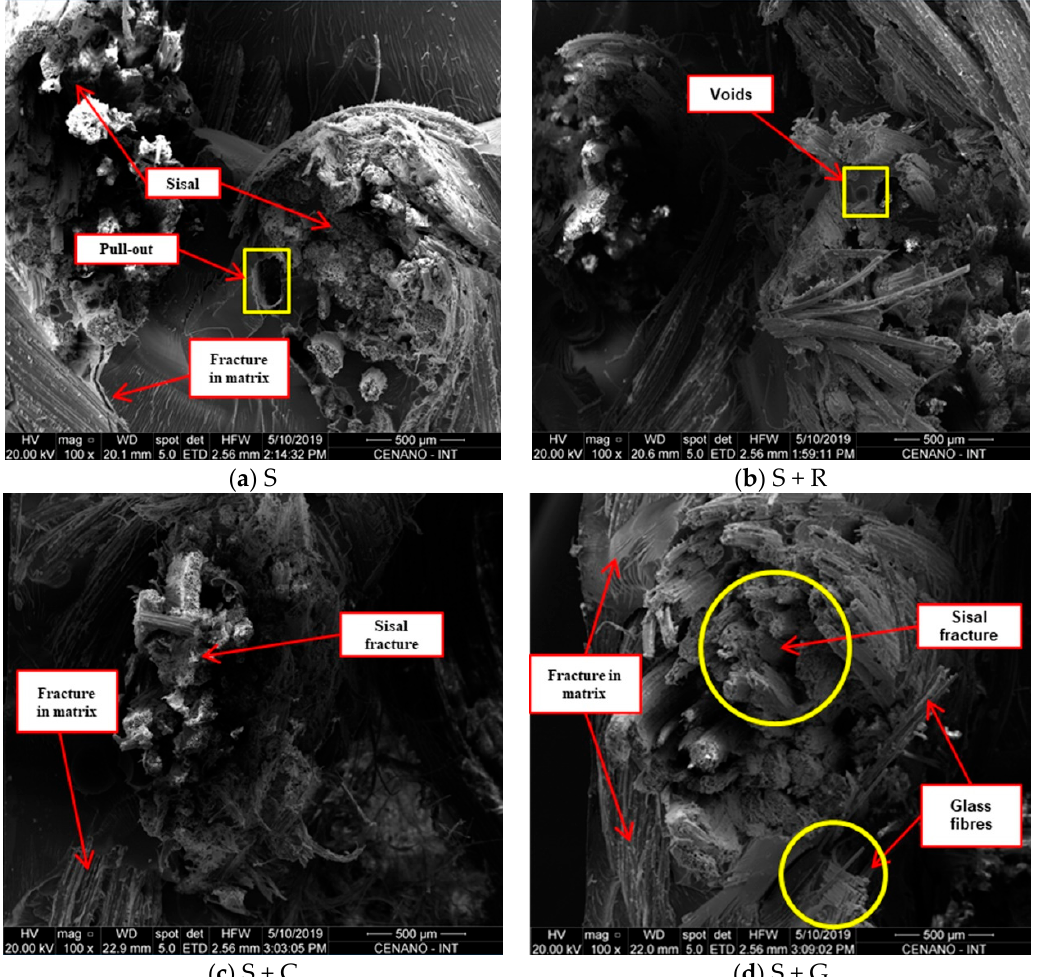
Figure 5. SEM images of fracture surface of composites as a function of hybridization after the impact tests ( a ) S; ( b ) S+R; ( c ) S+C and ( d ) S+G.